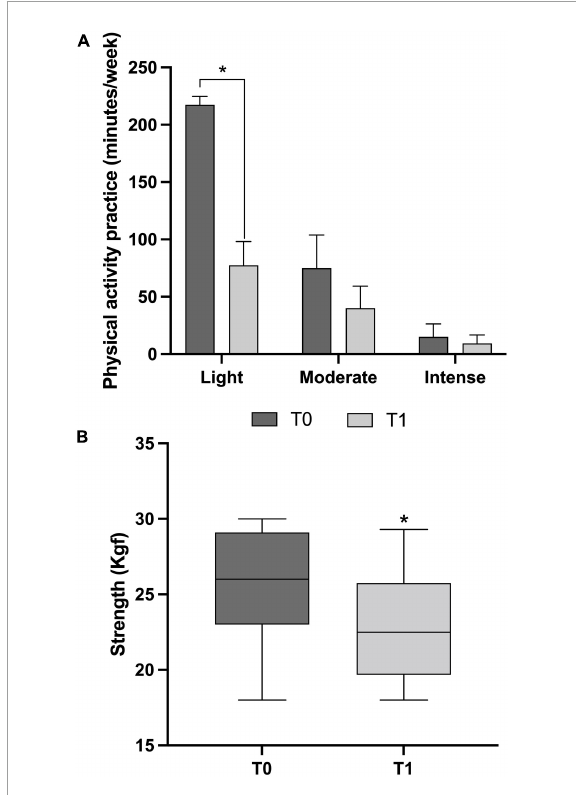
FIGURE1 Physical activity practice (minutes/week) and Strength (kgf) before (T0) and after 6 months of physical distancing (T1) of Brazilian older women ( n = 15). (A) Mean and standard deviation values for light (T0: 217.50 ± 47.13 and T1:77.50 ± 20.70), moderate (T0: 75.00 ± 28.91 and T1: 40.00 ± 19.18), and intense (T0: 15.00 ± 11.34 and T1: 9.37 ± 7.47), physical activity practice. (B) The boxplots show the median, minimum and maximum values for handgrip strength (T0: 27.05, min 22.50, max 30.00; T1: 22.50, min 18.00, max 29.03). * represents the difference between groups (paired Student t -test, p <